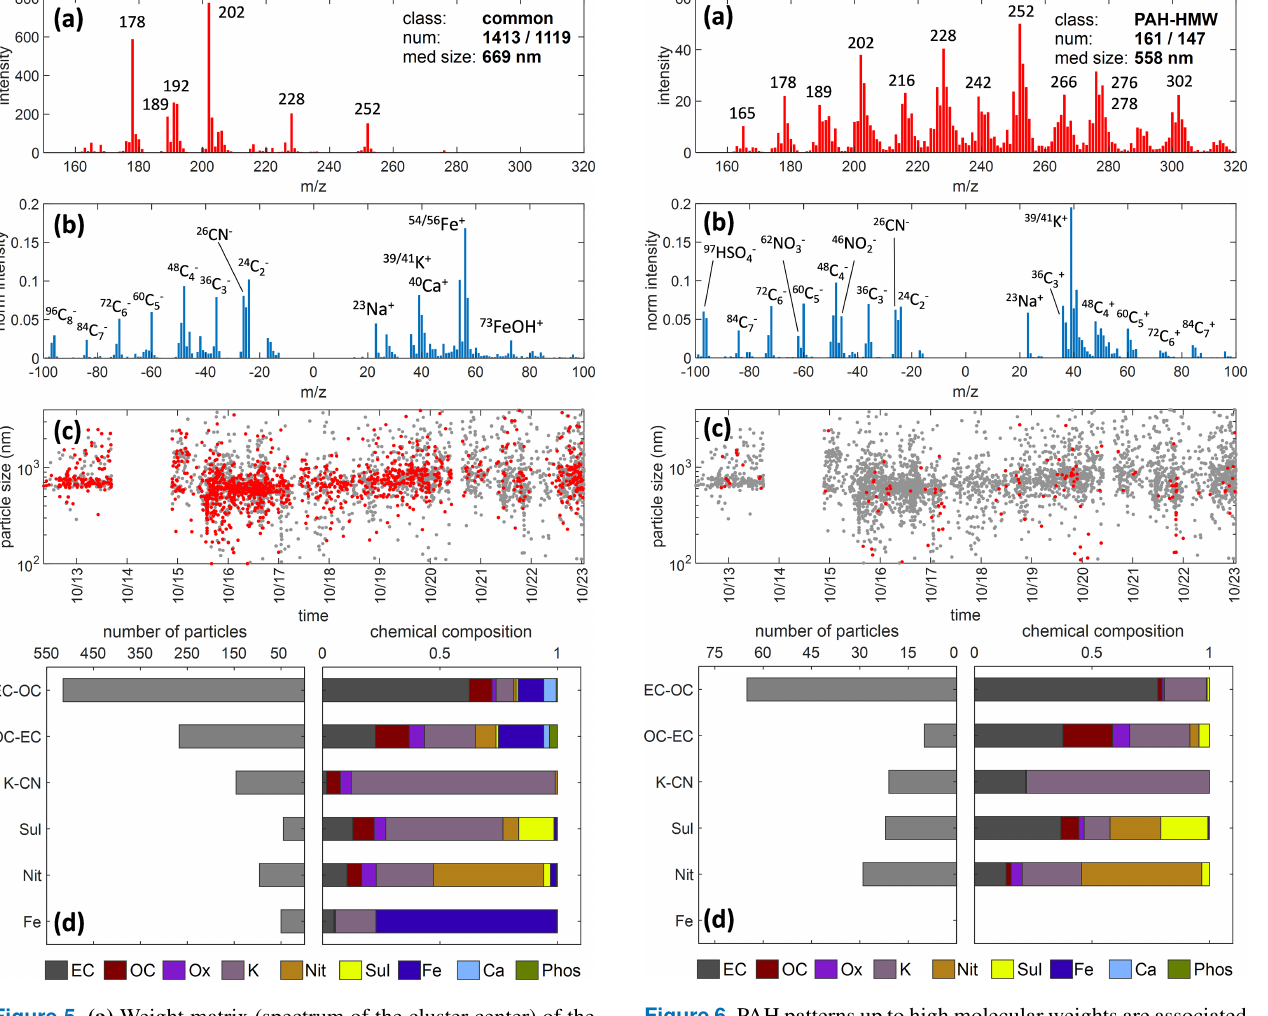
Figure 5. (a) Weight matrix (spectrum of the cluster center) of the most abundant common PAH class (1413 particles, whereof 1119 show additional LDI mass spectra with at least four peaks; med size: median vacuum aerodynamic diameter). (b) Averaged LDI mass spectra of the particles that belong to this cluster. (c) Oc- currence of these particles (red dots, n = 1413) within the mea- surement period ( x axis) and their vacuum aerodynamic diameter ( y axis). Grey dots: PAH-containing particles from the other PAH classes 2–10 ( n = 2333). Please note that the date format in this panel is month/day. (d) Left: number of particles in the subgroups as a result of sub-clustering the LDI signatures of particles in the com- mon PAH class. Here, the EC–OC particle type dominates. Right: averaged relative peak areas of the key inorganic components for the particles in the subgroups. Ion mass channels are as follows.